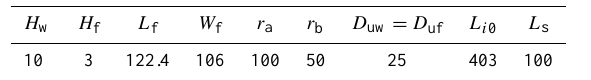
Table 2. Mechanical design parameters of LARM tripod leg mech- anism